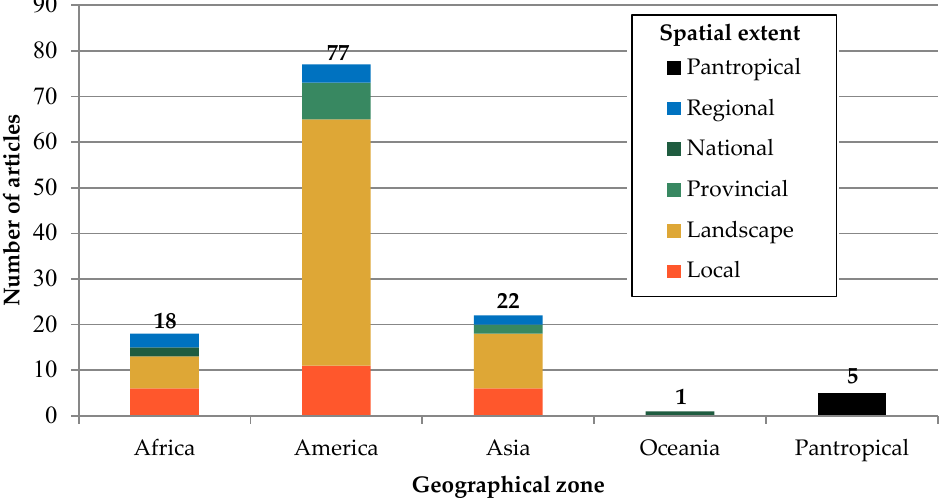
Figure 3. Frequency of articles according to their geographical area and their spatial extent.